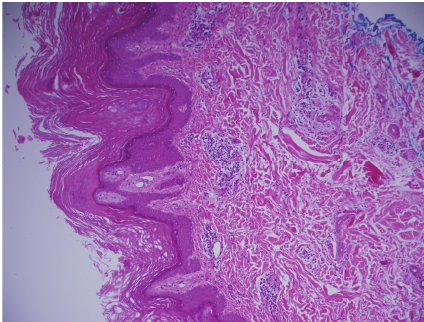
Figure 3: Skin biopsy shows acanthosis and papillomatosis with focal dermal perivascular lymphocytic infiltrate (10x).